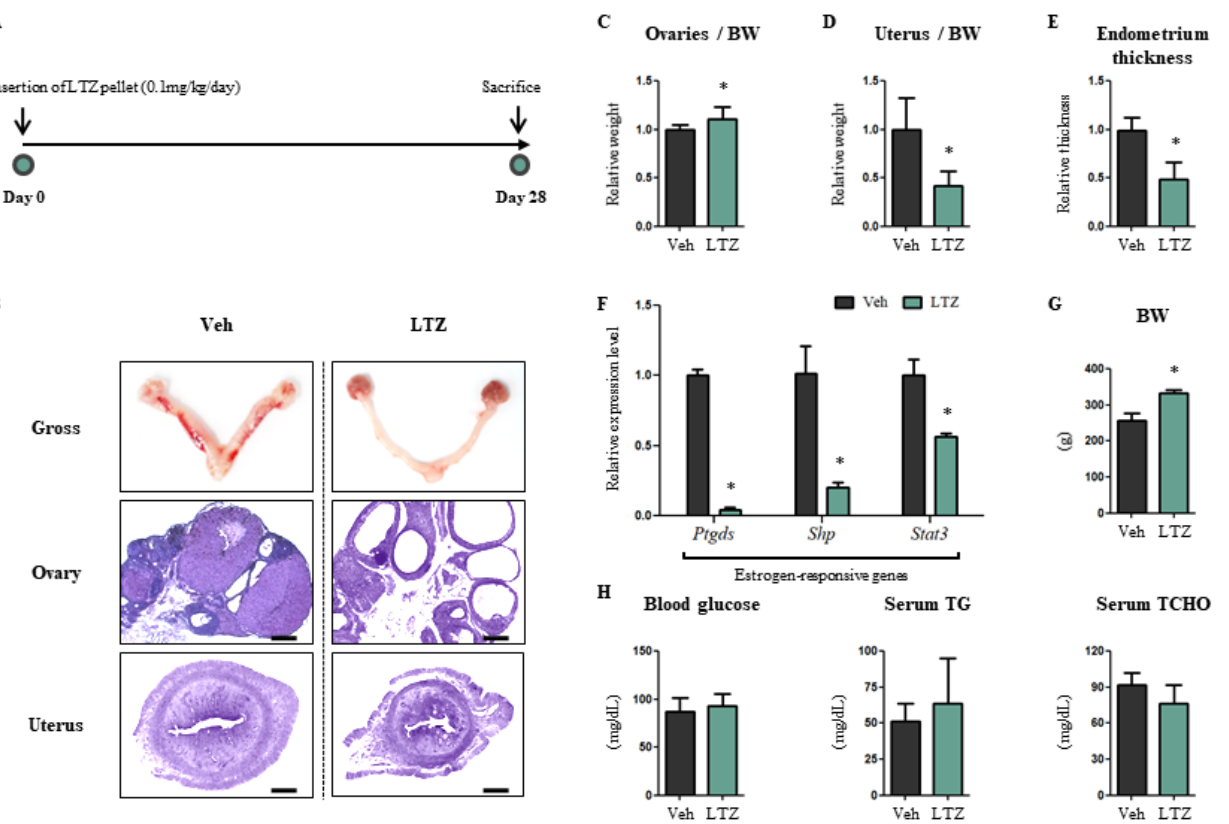
Figure 1. Letrozole creates a low estrogenic environment in female rats. ( A ) Schematic diagram shows the schedule of an animal experiment. Norway rats aged 3 weeks were acclimatized for a week and slow-releasing pellets which were either vehicle (Veh) or letrozole (LTZ) were inserted into subcutaneous parts for four weeks. ( B ) To validate fluctuation in the estrogenic environment, female reproductive tissues including ovaries and uterus were observed as gross and were examined via haematoxylin and eosin stain (H&E). Scale bar = 1000 µm. ( C ) Relative weight of ovaries to body weight was measured. ( D ) Relative weight of uterus to body weight was measured. ( E ) En- dometrium thickness was measured quantitatively using Image J software. ( F ) mRNA levels of estrogen-responsive genes were determined via quantitative RT-PCR with uterus tissues. Mouse 60S acidic ribosomal protein P0 (mRPLP0) was used as internal control. ( G ) Body weight was mea- sured at four weeks after pellets were inserted. ( H ) Hematological profiles including blood glucose, serum triglyceride (TG) and serum total cholesterol (TCHO) were measured. The values stand for mean ± S.D. * p < 0.05 compared to